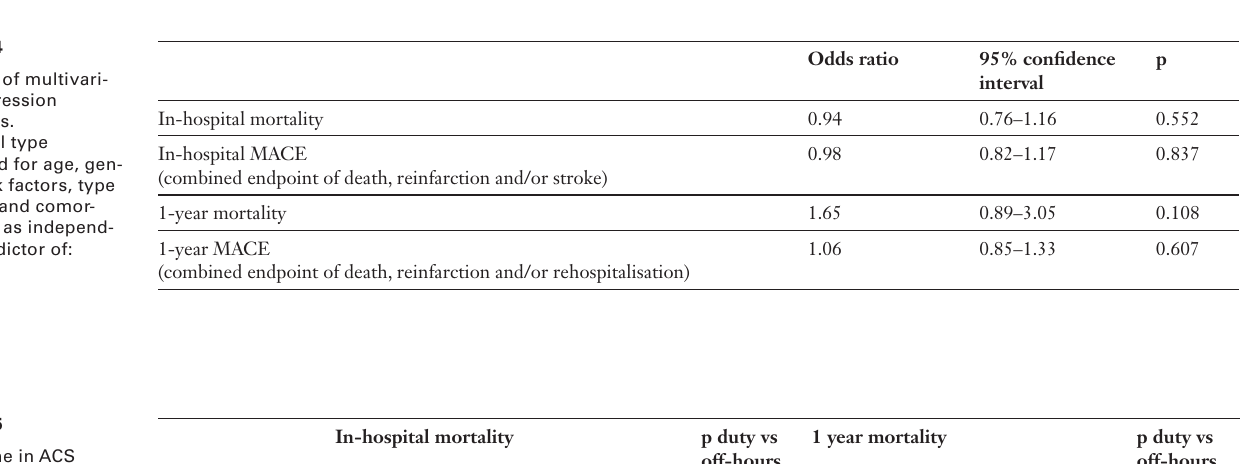
Outcome in ACS patients according to admission time and hospital